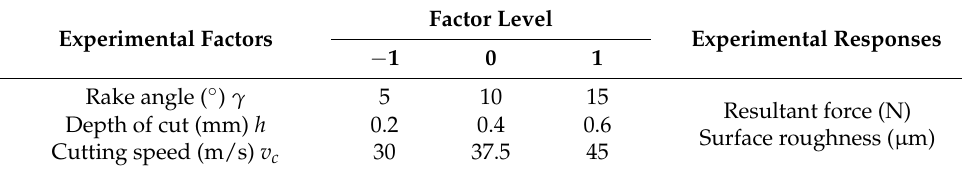
Table 3. Cutting factors, levels, and experimental responses.